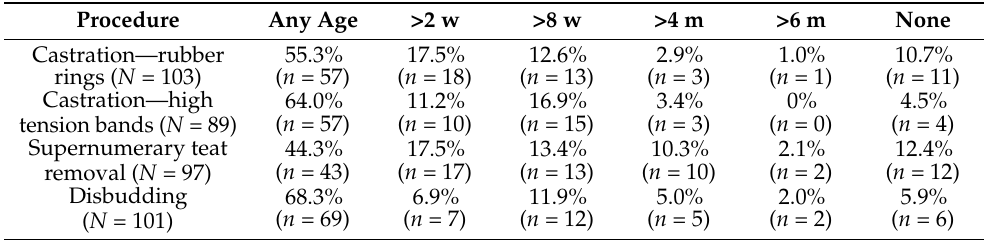
Table 10. The percentage (number) of veterinarians that identified an age beyond which it is necessary to provide postoperative analgesic for calves across certain husbandry